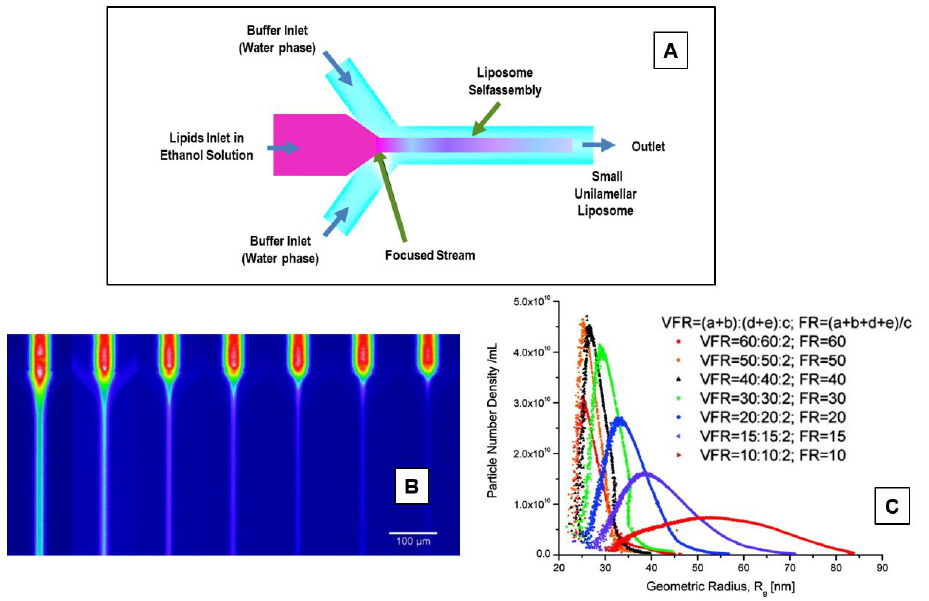
Figure 14. Schematic representation of a three-inlet microfluidic setup, ( A ). Confocal microscopy (false-color) pictures of the hydrodynamic focusing of an isopropyl alcohol (IPA) stream (that contains sulforhodamine ( B ) by two (aqueous buffer) streams, for 7 flow rate ratios (FRRs), increasing from 5 to 35 (increments of 5 from left to right) at a total constant volumetric flow rate VFR = 100 µ L/min ( B ). Final liposome size distribution at different FRRs ( C ). Adapted with permission from Jahn et al. [129], Copyright 2007 American Chemical